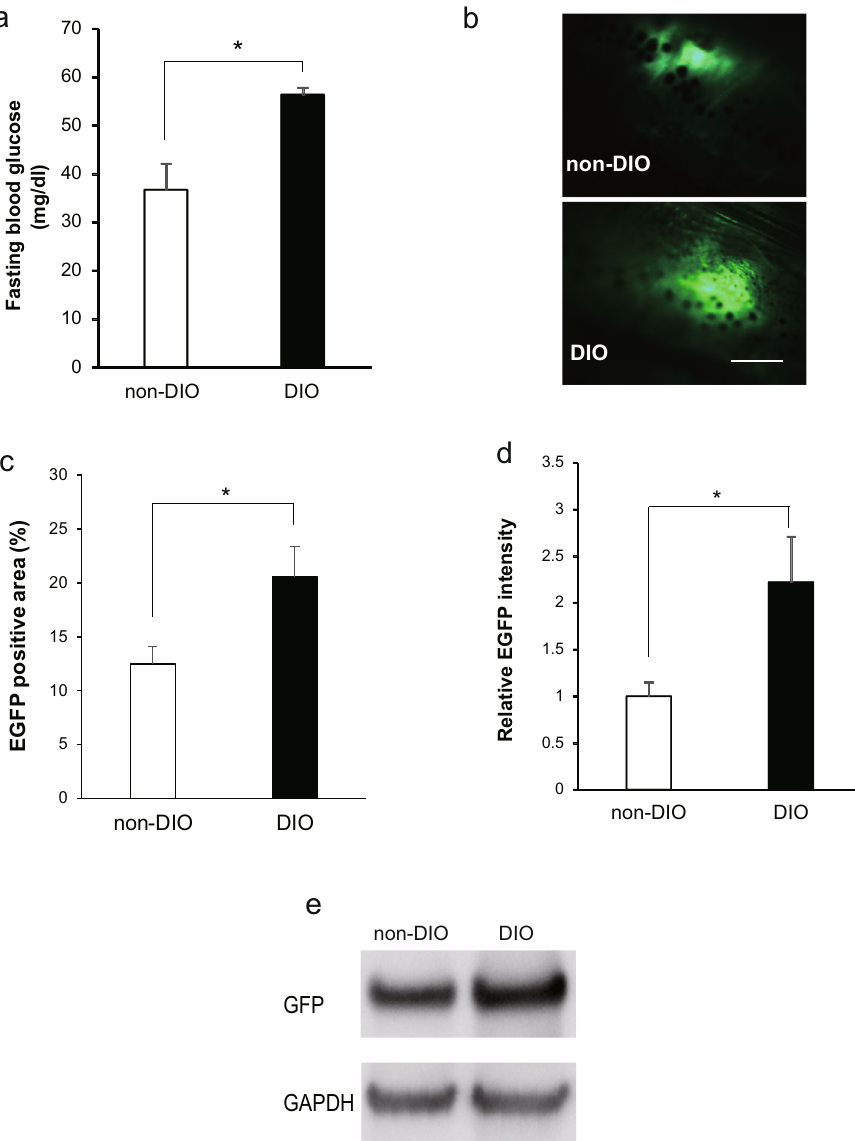
Figure 3. Increased insulin production in DIO zebrafish. ( a ) Fasting blood glucose concentrations of ins- EGFP zebrafish after 3 months of normal feeding or overfeeding. n = 10. ( b ) Insulin-EGFP signals in exocrine pancreas were monitored in non-DIO and DIO ins-EGFP zebrafish by fluorescence stereoscopic microscopy. Scale bar = 0.5 mm. ( c ) Graph of the percentage of EGFP positive signal area in entire image. n = 3. ( d ) Graph of relative EGFP intensities from panel b. n = 3. ( e ) Western blot analysis for GFP signals in liver-pancreas tissue of non-DIO and DIO ins-EGFP. Full-length blots are presented in Supplementary Fig. S3. Values are means ± SE. * P < 0.05, ** P < 0.01 vs. the non-DIO